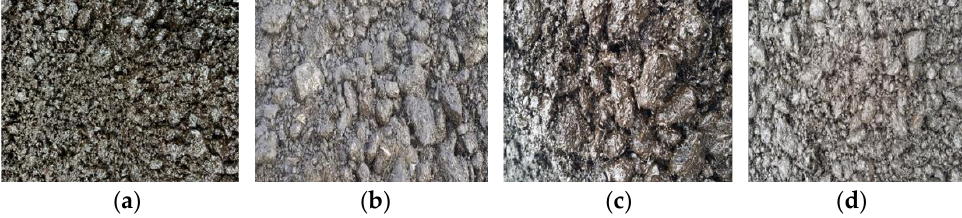
Figure 14. Fiber macro-distribution state in loose CRAM: ( a ) process A; ( b ) process B; ( c ) process C; ( d ) process D.